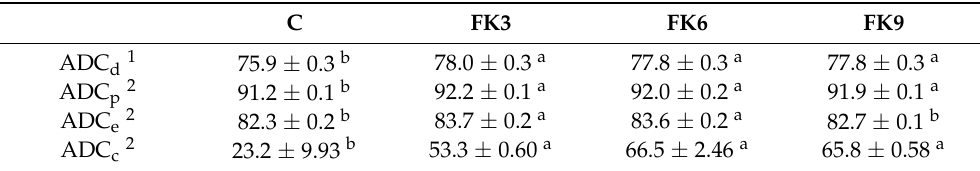
Table 6. Apparent digestibility coefficient of nutrients in largemouth bass fed diets with various FK levels (%, means ± SEM. n =